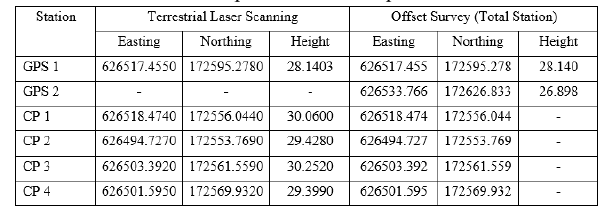
Table 3.3 Data validation of Terrestrial Laser Scanning and Offset Survey